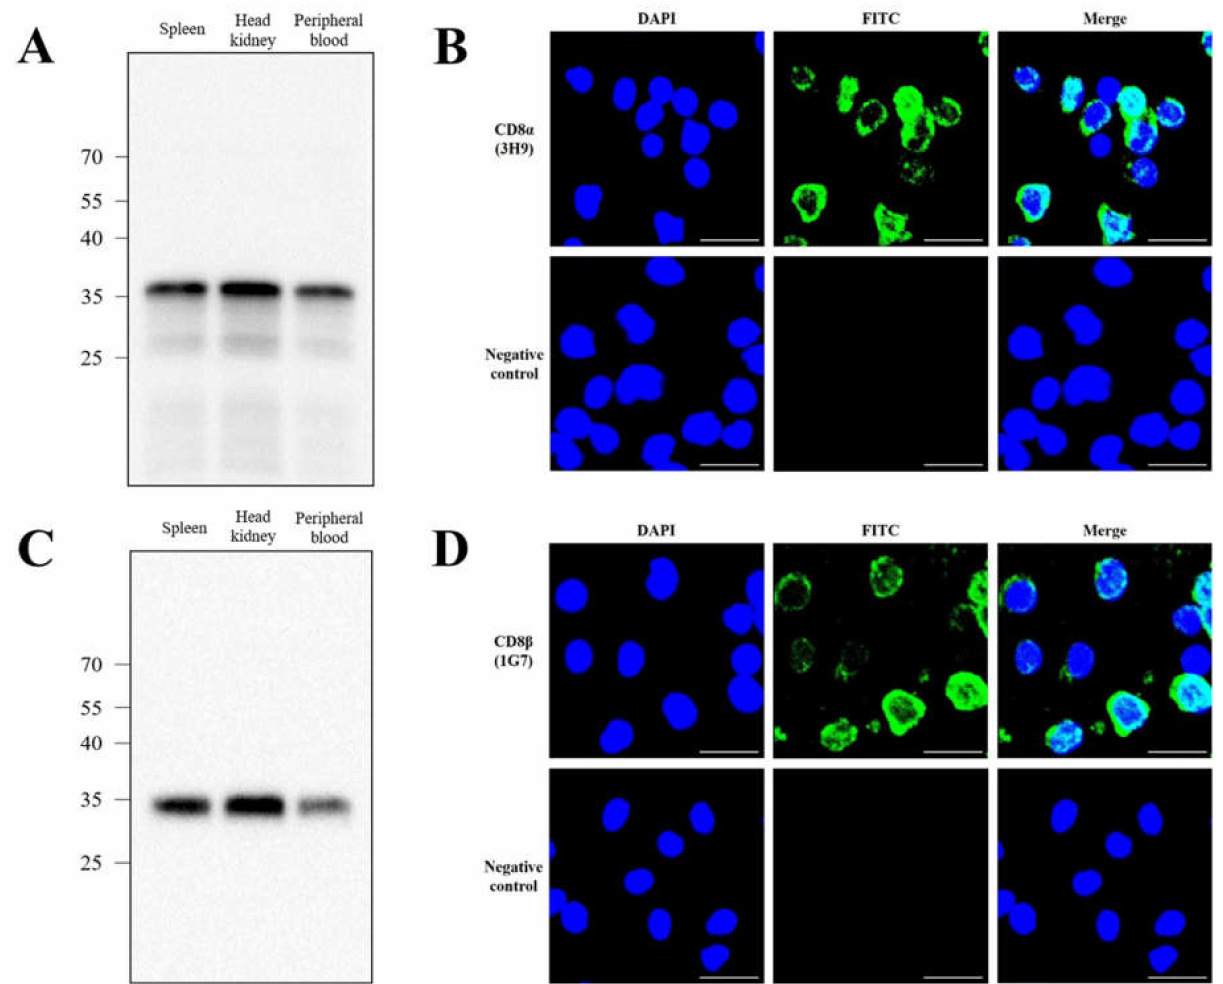
Figure 4. Reactivity of anti-CD8 α mAb and anti-CD8 β mAb to flounder leukocytes. ( A ) Leukocytes from the spleen, head-kidney and peripheral blood of olive flounder were subjected to Western blot analysis, and the bands recognized by the anti-CD8 α mAb (3H9) were detected. ( B ) For immunofluorescence, leukocytes isolated from head-kidney were stained with anti-CD8 α mAb (3H9), followed by FITC. ( C ) Leukocytes from the spleen, head-kidney and peripheral blood were recognized by the anti-CD8 β mAb (1G7). ( D ) Immunofluorescence staining of head-kidney leukocytes were stained with anti-CD8 β mAb (1G7), followed by